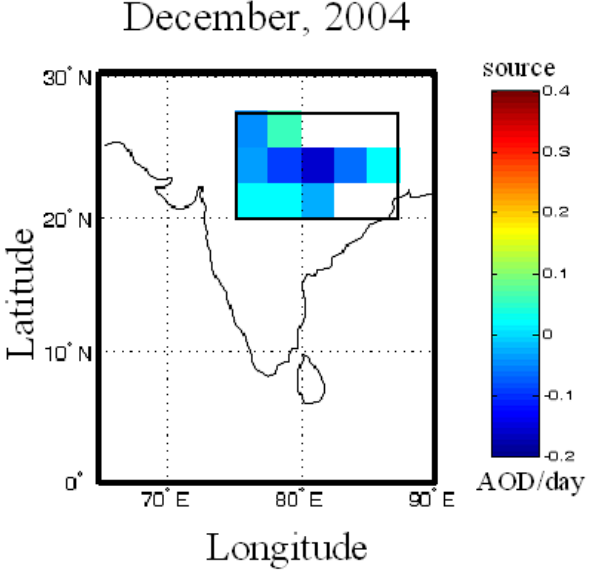
Fig. 7. Spatial distribution of source strength averaged for the month of December 2004 over the study domain, after incorporating aerosol loss